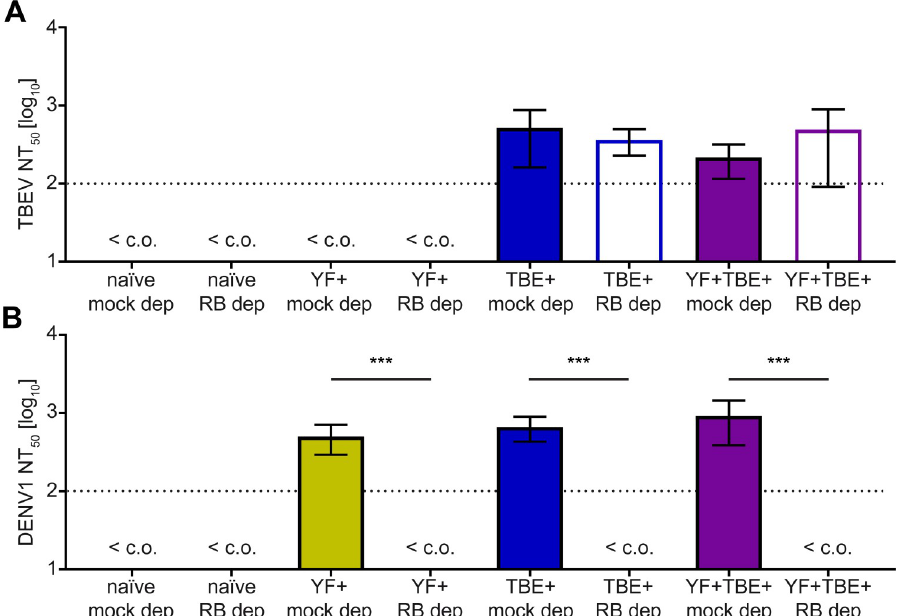
Fig 8. Effect of depletion of cross-reactive antibodies from serum pools with Rio Bravo virus E on TBE and dengue virus neutralization. (A) TBE virus NT. (B) Dengue virus NT. IgG-containing serum pools were further depleted with RB virus E protein as described in Methods. Colored columns: mock depletion, empty columns: RB depletion. The dotted line indicates the cut-off (c.o.) of the assay. Mean NT 50 titers were calculated from two (A) or three (B) independent experiments. Error bars represent the range (A) or standard error of the mean (B). Significant differences between mock depletion and RB depletion are indicated by asterisks (2-way ANOVA with linear contrasts); ��� , p < 0.001. TBEV, tick-borne encephalitis virus; DENV1, dengue virus serotype 1; mock dep, IgM and mock- depleted serum pool; RB dep, IgM and Rio Bravo virus E-depleted serum pool.